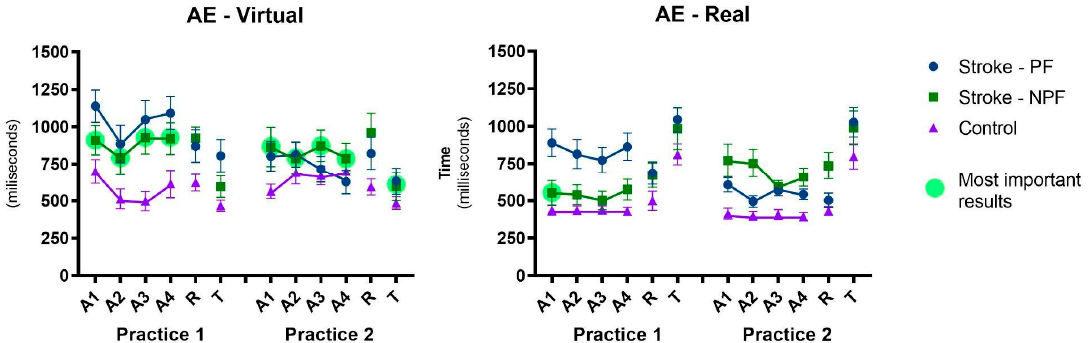
Figure 3. Representation of mean and standard error of the absolute error (AE) pattern for blocks, sequences, and groups on interfaces in all phases of the protocol, for stroke and control groups. AE: absolute error; A1: first acquisition block; A2: second acquisition block; A3: third acquisition block; A4: fourth acquisition block; R: Retention test block; T: Transfer test block—changing device; PF: paretic first; NPF: non-paretic first. • Most important result (green sphere): only in the virtual interface, the participants with stroke that practiced with non-paretic limb first (Practice 1) showed better performance in the second sequence with paretic limb (Practice 2), and this group presented better results in the transfer to the real interface (Transfer, Practice 2). This can be reinforced by the comparison between the result of this transfer with the paretic upper limb group on real interface (i.e., Transfer of Practice 2 versus A1 of Practice 1—real interface).